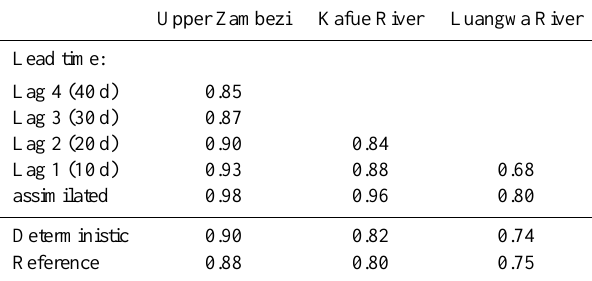
Table 3. Nash-Sutcliffe efficiency of the different forecast lead times up to the maximum possible lead time ( 1τ S ). For comparison the Nash-Sutcliffe efficiency of the deterministic model run and the reference method are indicated.